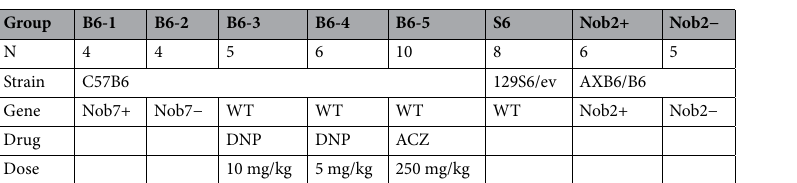
Table 1. Mouse groups used for OCT